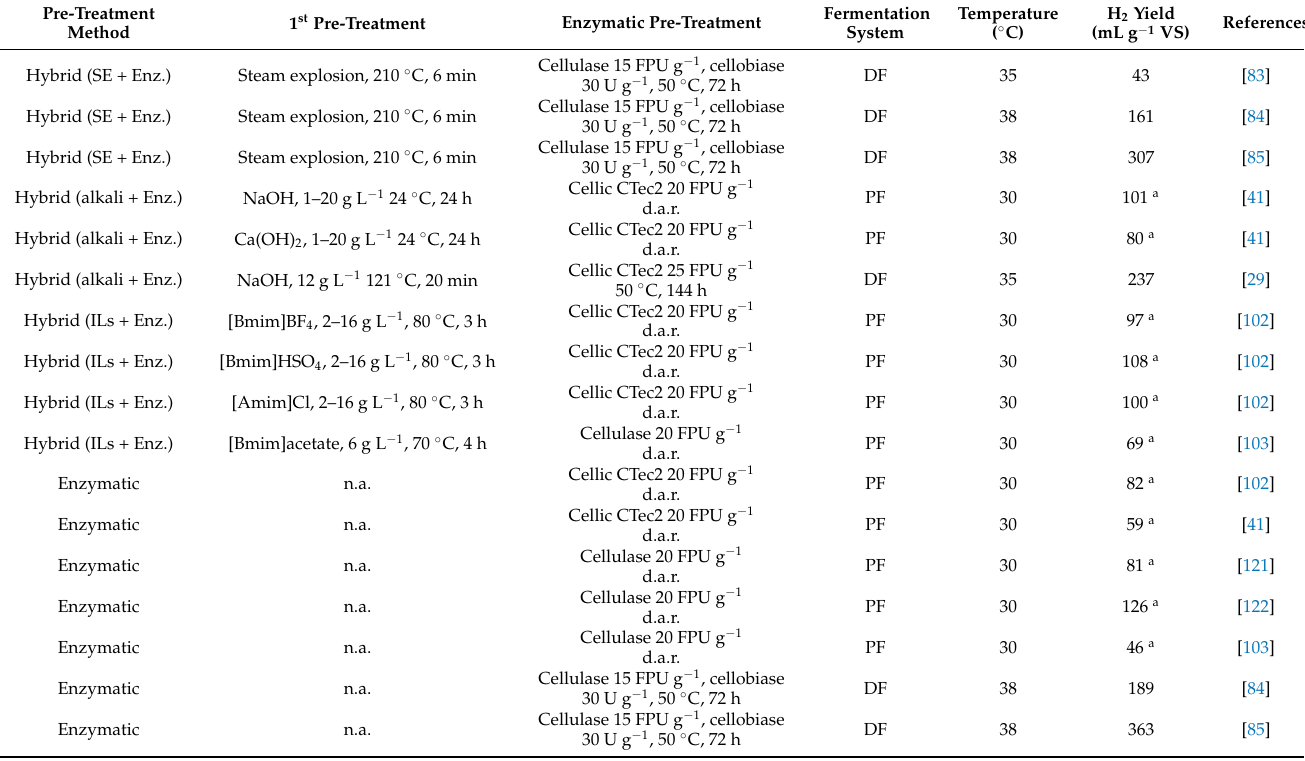
Table 3. Hydrogen production from giant reed biomass after hybrid or enzymatic